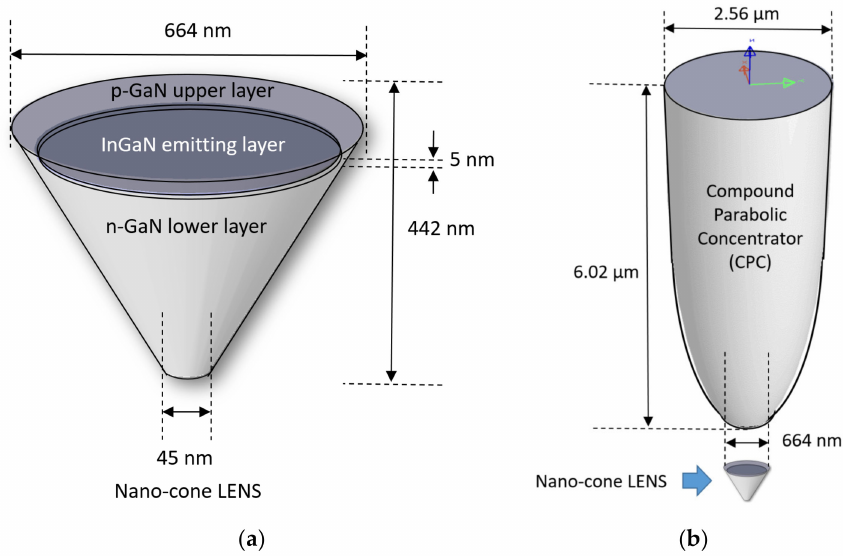
Figure 1. 3D representation of the device structure. ( a ) Nano-cone light emitting nano-pixel structure (LENS); ( b ) Nano-cone LENS with compound parabolic concentrator